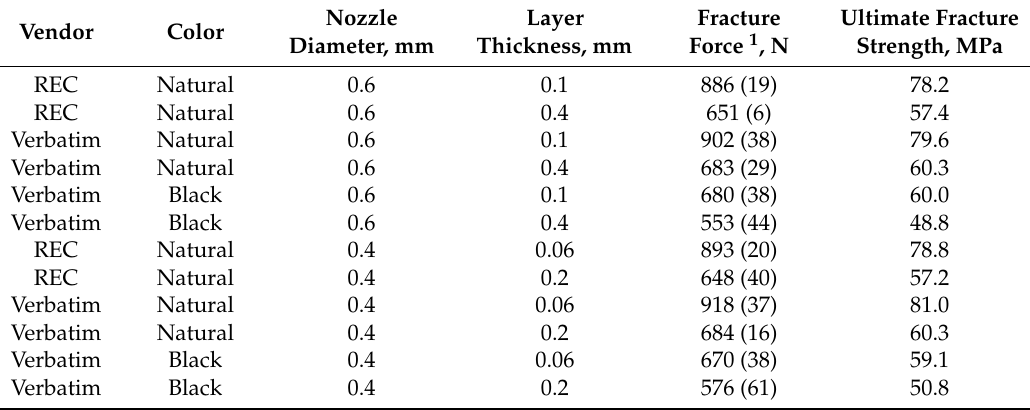
Table 2. Experimental data on the influence of geometrical parameters (nozzle diameter and